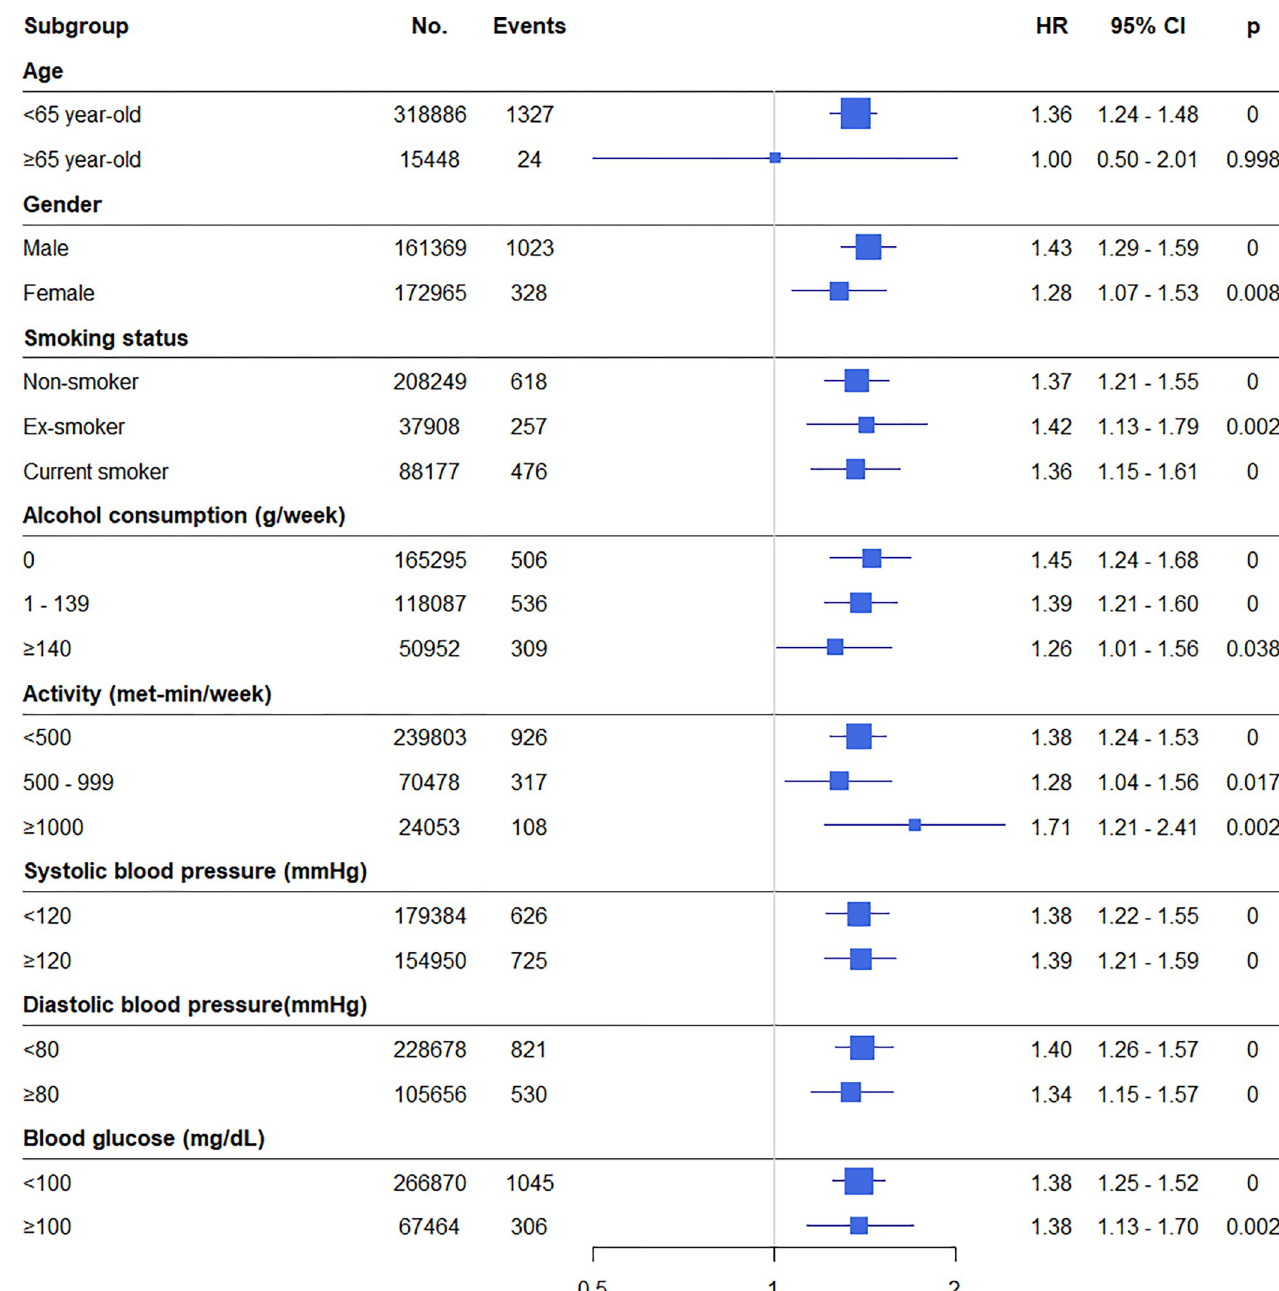
Fig 3. Forest plots of hazard ratios for new-onset SA stratified by various clinical characteristics. HR, hazard ratio; CI, confidence interval.